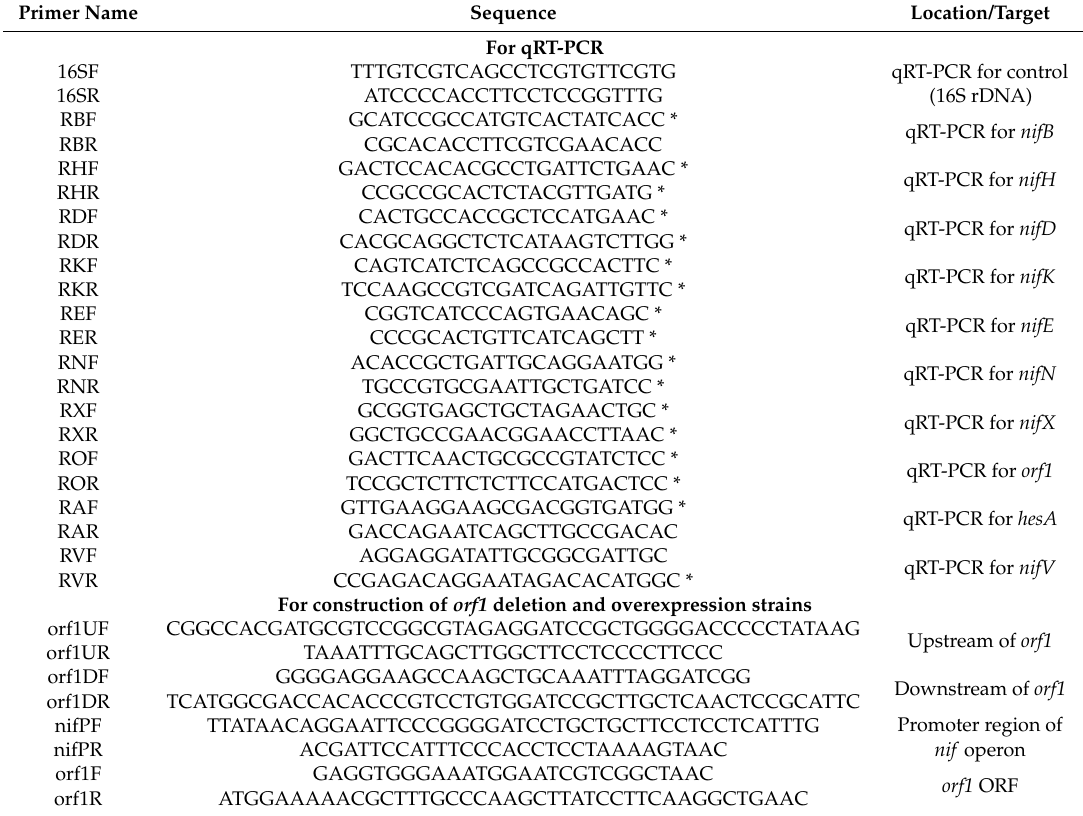
Table 2. Primers used in this